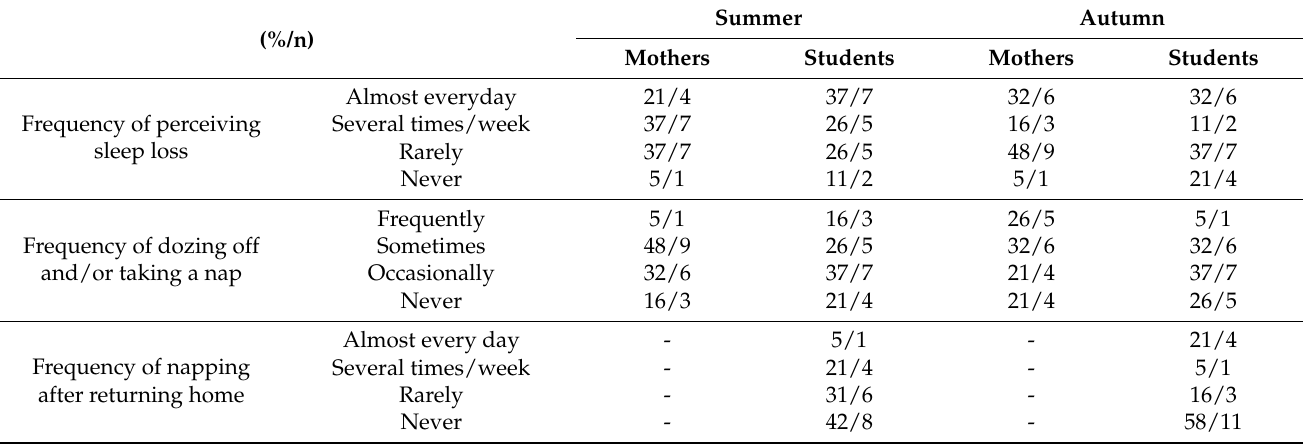
Table 6. The results of daytime sleep